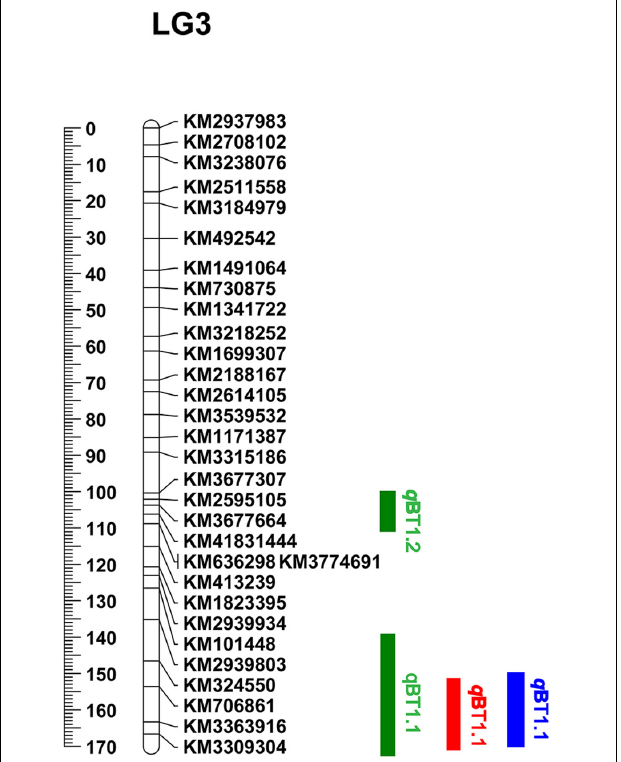
FIGURE 3 | QTL results of bolting using KASP genetic linkage map. The color Green, Red, and Blue respect BC 1a , BC 1b , and F 2 populations, respectively.